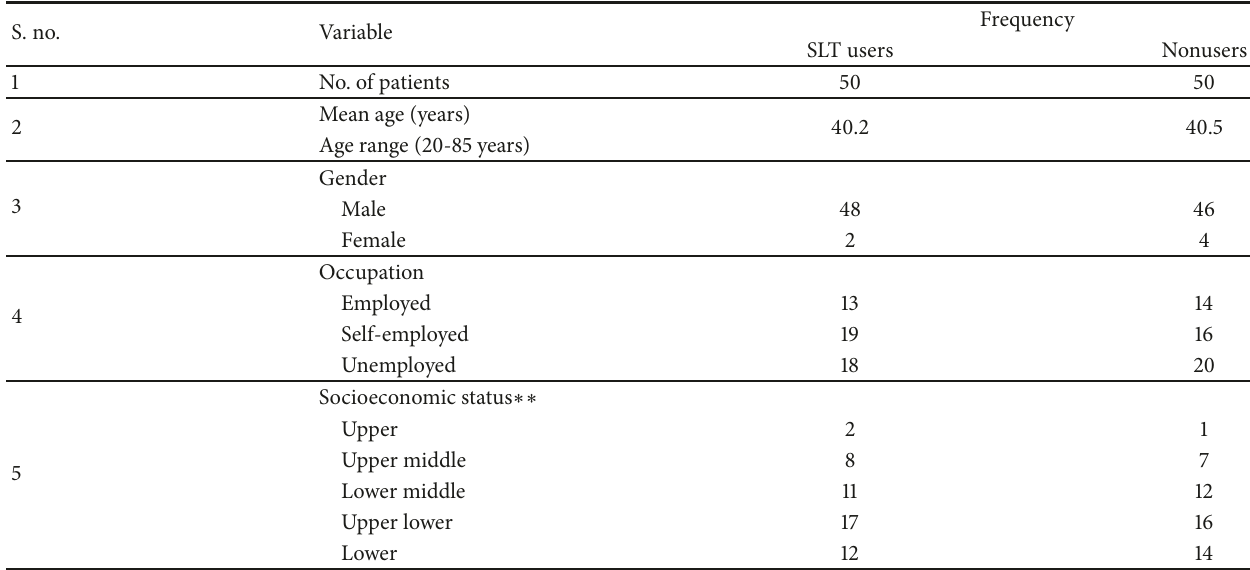
Table 1: Sociodemographic characteristics of SLT users and